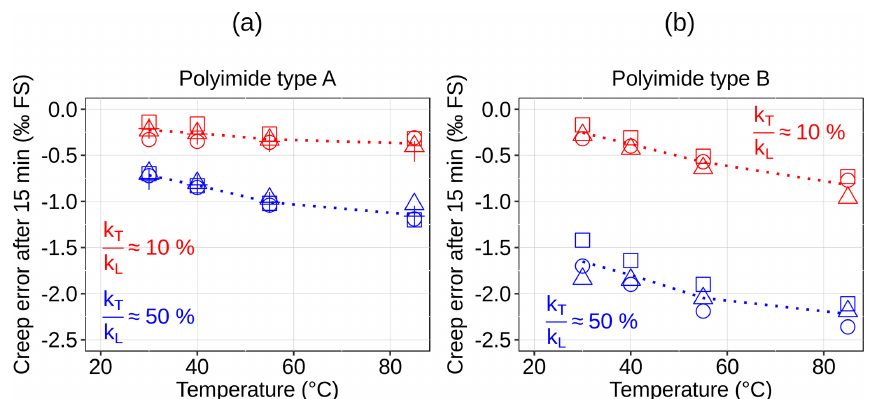
Figure 8. Creep error after 15min of aluminum bending beams with attached Ni 90 Cr 10 − C thin-film SGs depending on the ratio k T /k L . The SGs are based on (a) polyimide type A and (b) polyimide type B. Every marker symbol represents a sensor specimen; the dotted lines connect the average values (not shown here).